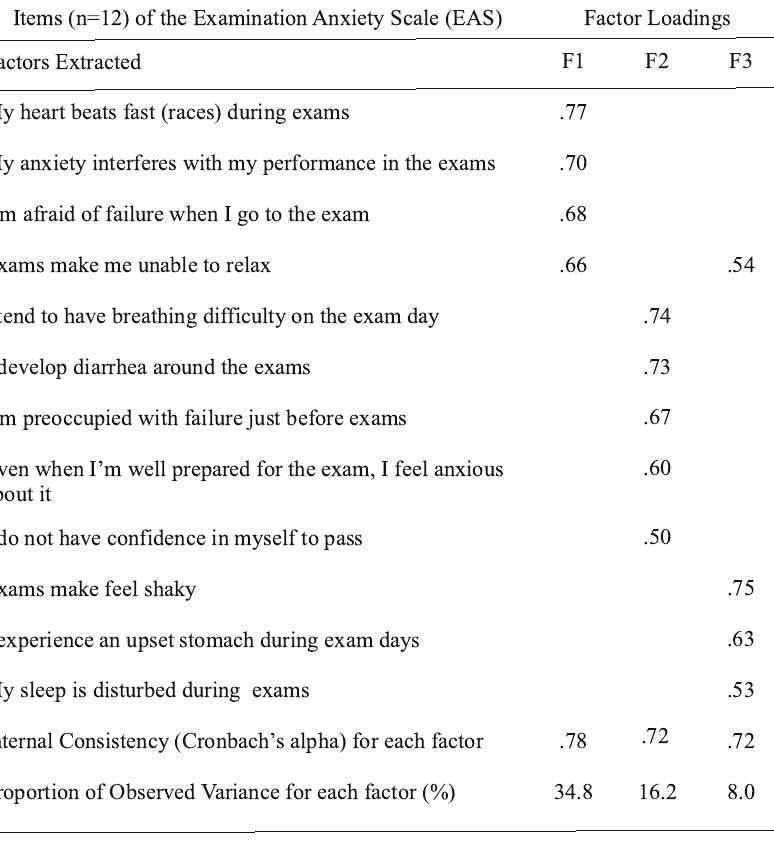
Rotated Factor Matrix Examination Anxiety Scale